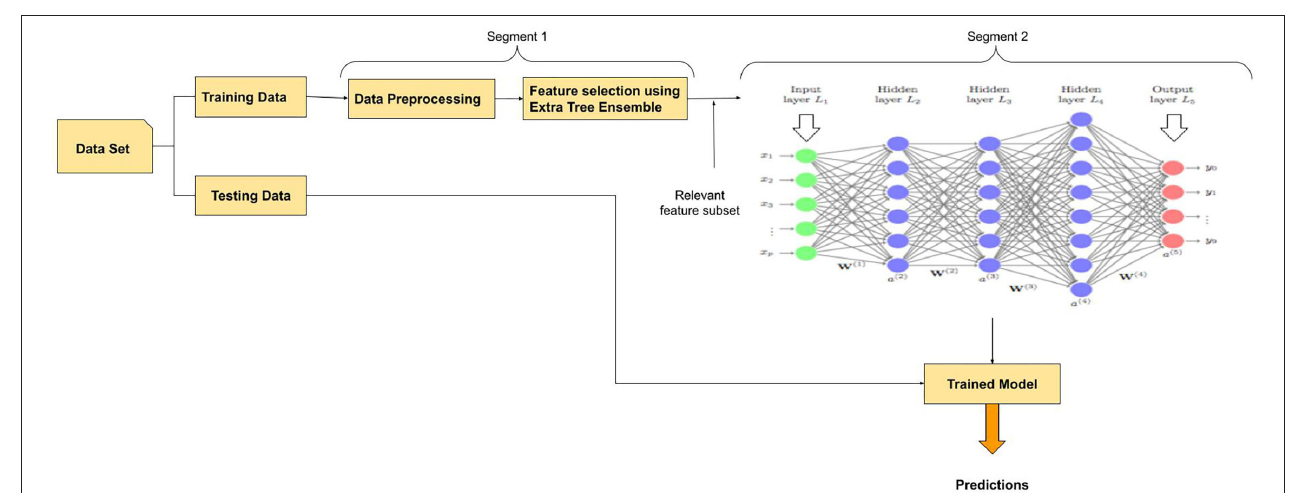
FIGURE 1 | Flowchart for the proposed